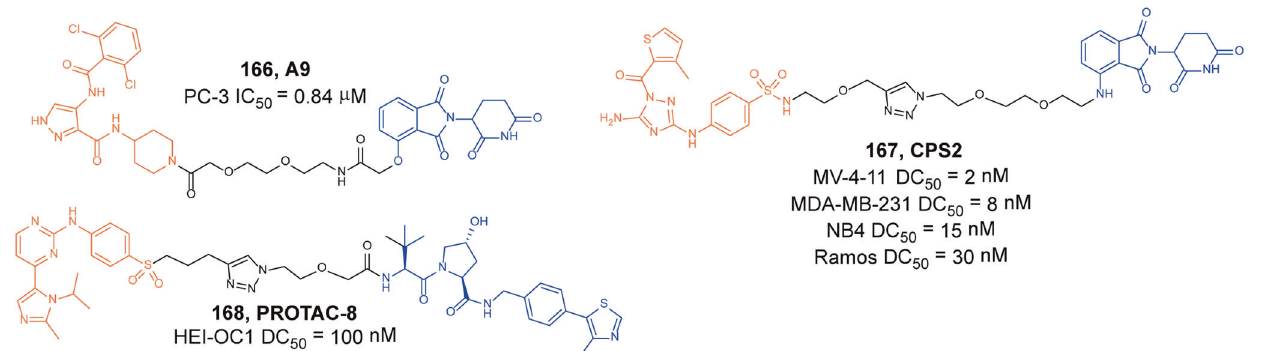
Fig. 43 The representative PROTACs targeting